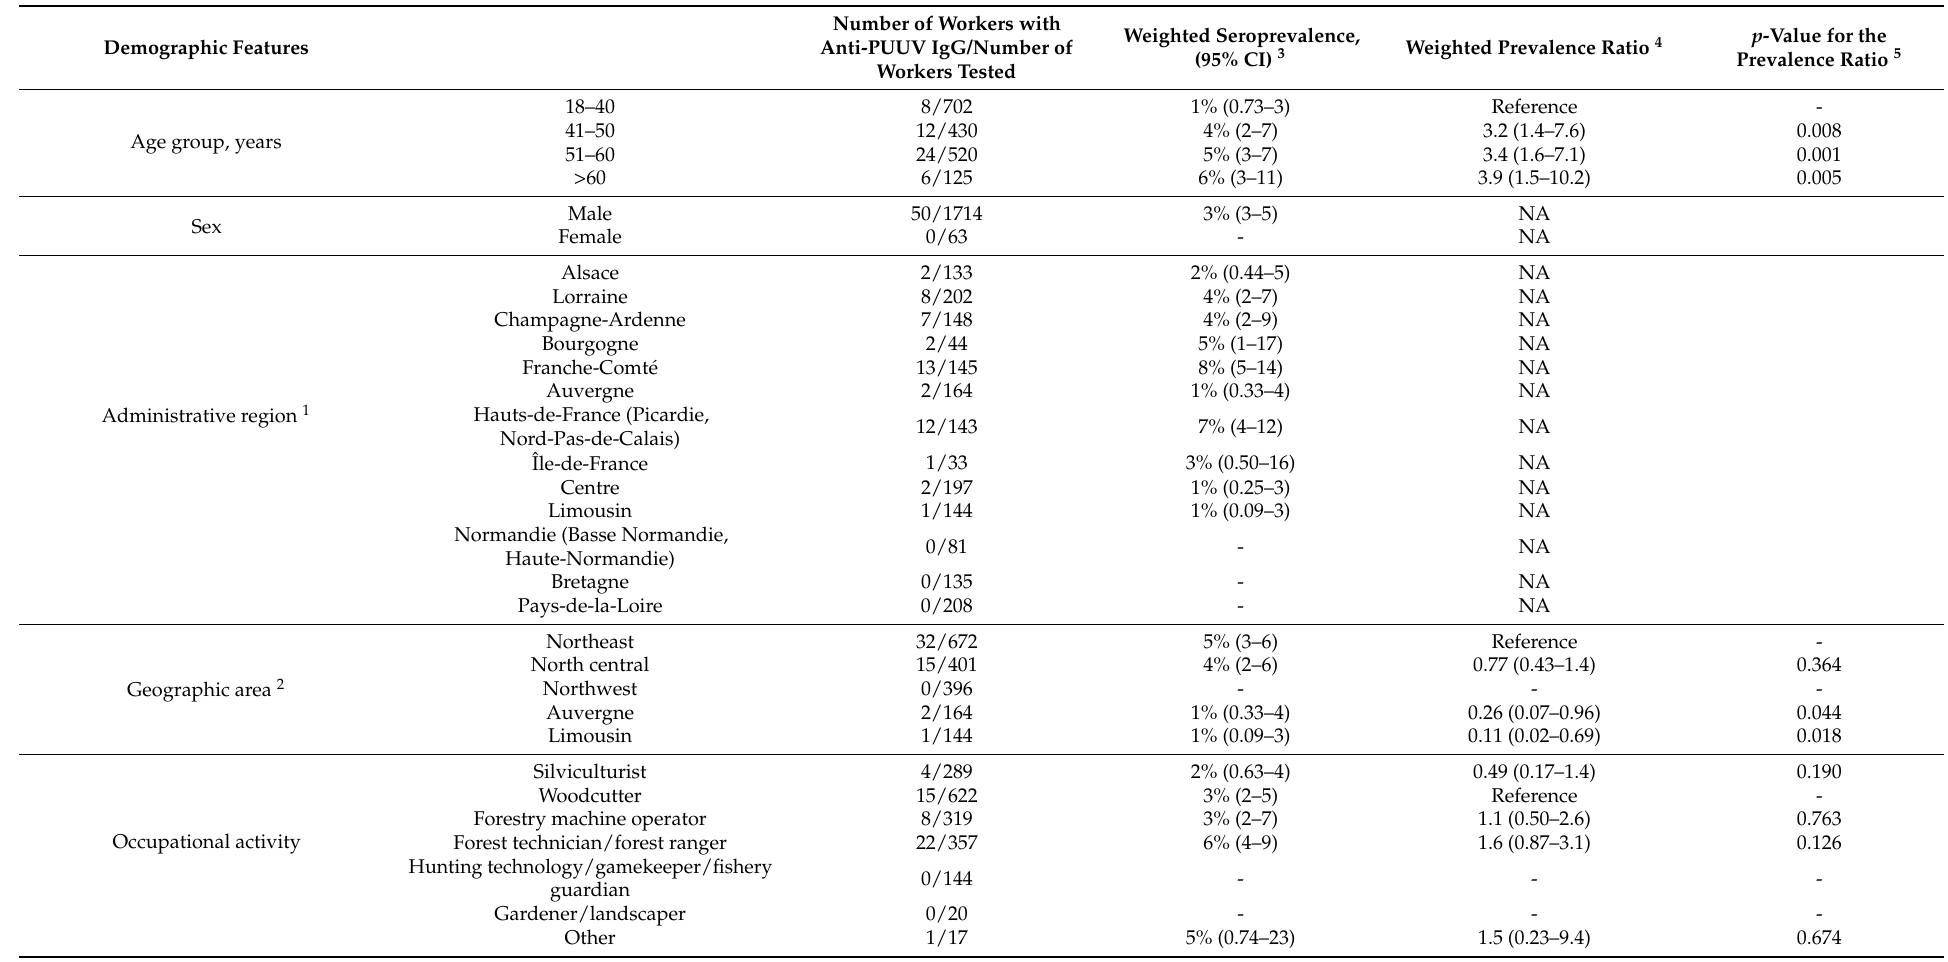
Table 2. Weighted prevalence and prevalence ratio of immunoglobulin G (IgG)against Puumala orthohantavirus (PUUV) antigens among forestry workers, northern France,